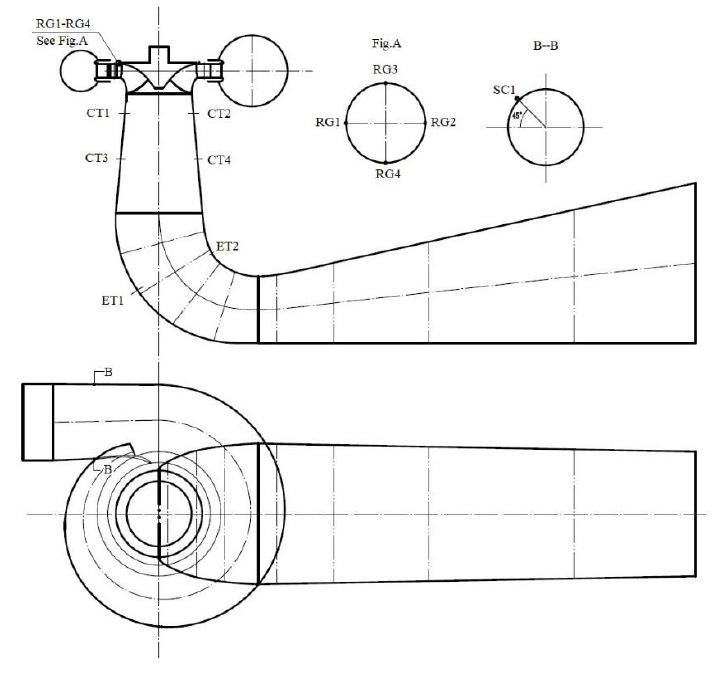
Figure 6. Positions of pressure sensors.